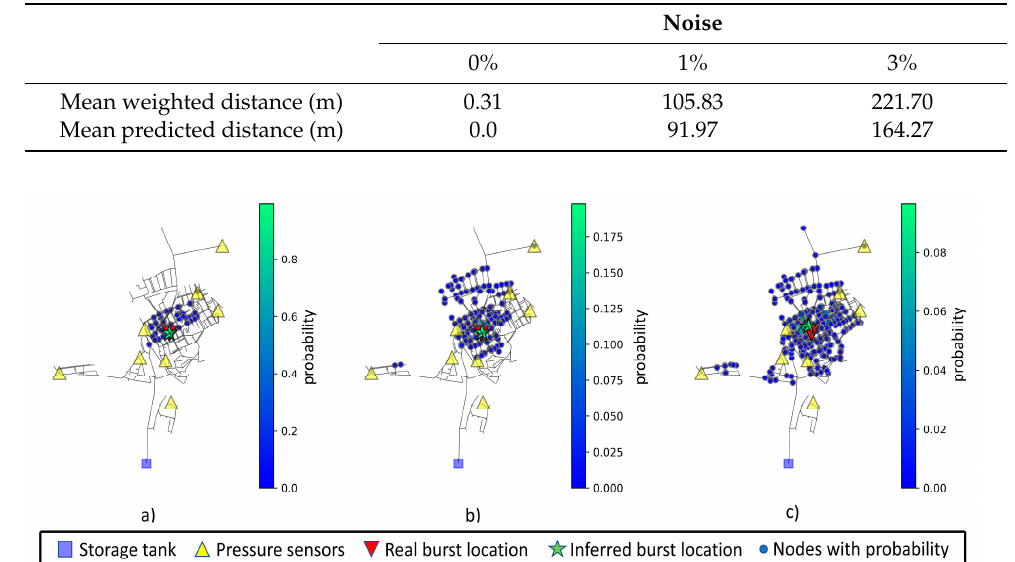
Figure 13. Network prediction areas for node 285, considering ( a ) 0% noise level, ( b ) 1% noise level, and ( c ) 3% noise level. Nodes with higher probability are displayed in a greener color and with lower probability in a bluer color, following the scale presented to the right of each chart.